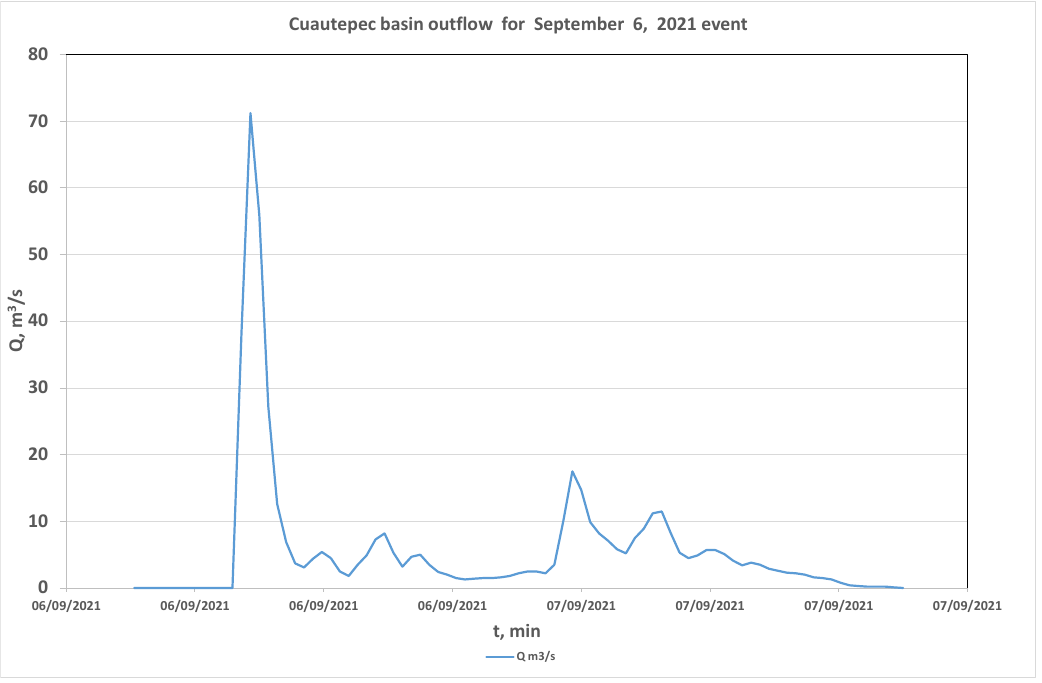
Figure 8. Flash flood hydrograph produced by the historic storm of September 2021. Estimated with Hec ‐ HMS. Cuauhtepec Basin, Edomex.